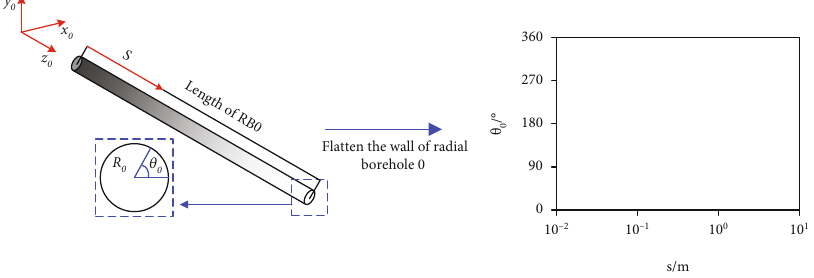
Figure 3: Schematic diagram of fl attening the radial borehole 0 wall. Table 1: Basic calculation